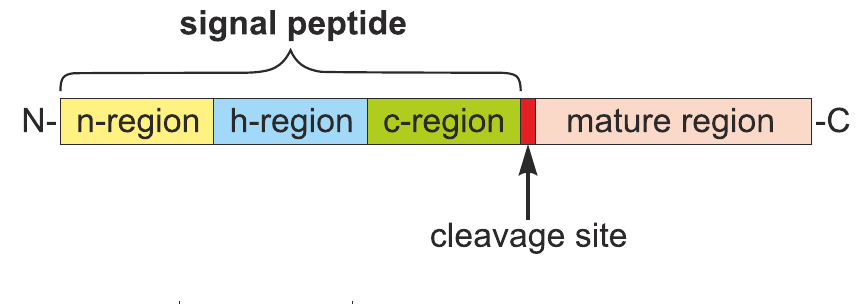
Figure 1. Organization of a typical signal peptide (SP). The lengths of SP regions are not drawn in